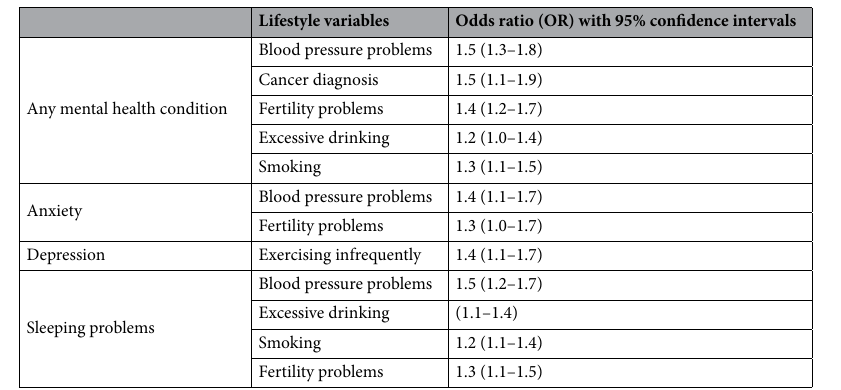
Table 1. Firefighters’ other health and lifestyle factors found to be significantly associated with their mental health. Odds ratios were adjusted for several mental health risk factors (e.g. sleeping problems) and/or sleep disturbances (e.g. age), detailed in Supplemental File S2, Tables S2, S3 and S4. Excessive drinking refers to the consumption of more than 15 units of alcohol per week (one unit equals 10 mL of pure alcohol).